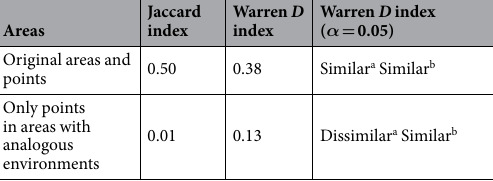
Table 1. Examination of the environmental similarities between native and invasive Gray Squirrel ( Sciurus carolinensis ) populations. a British Islands occurrences versus North America background. b North America occurrences versus British Islands